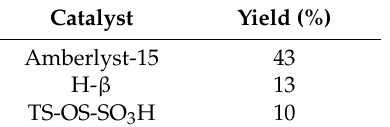
Table 2. Condensation reaction of phenol with ethyl acetoacetate with different heterogeneous catalysts. 1 Catalyst Yield (%) Amberlyst-15 43